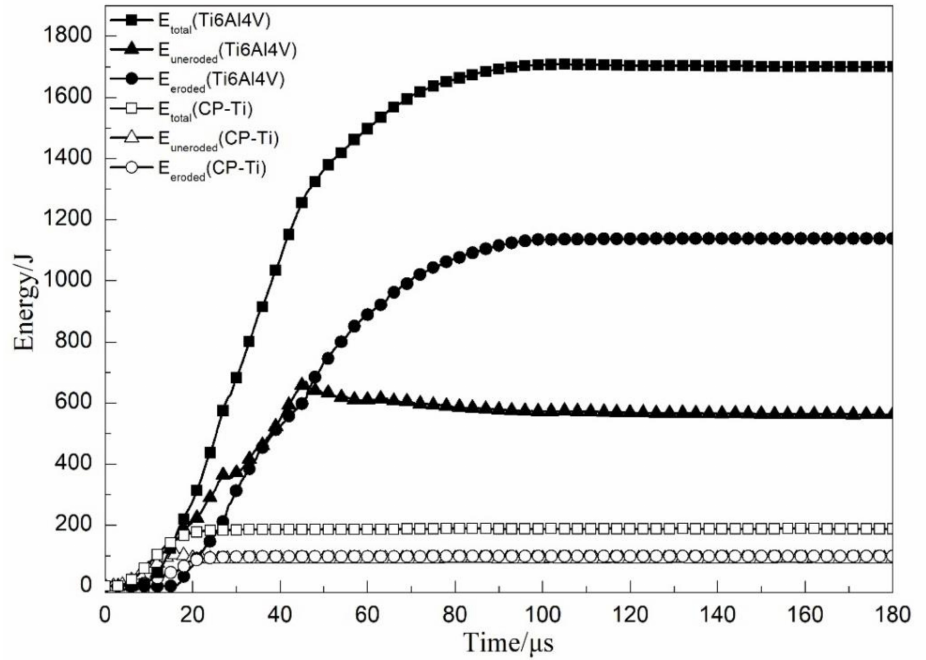
Figure 8. Energy absorption history curve of Ti6Al4V and CP-Ti during the penetration process of CPTi /